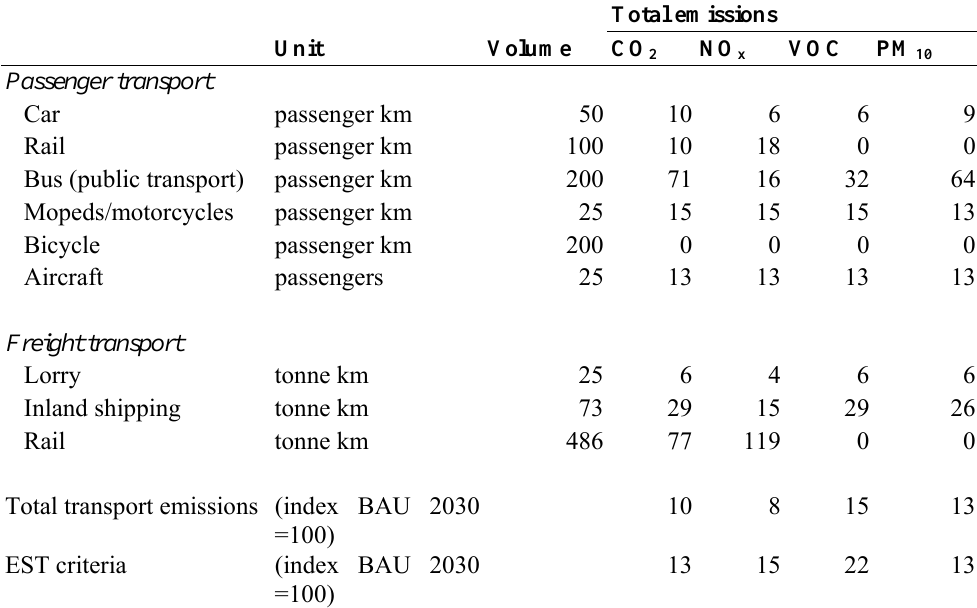
Table 3: Vehicle use and total CO in 2030, index business-as-usual 2030 =